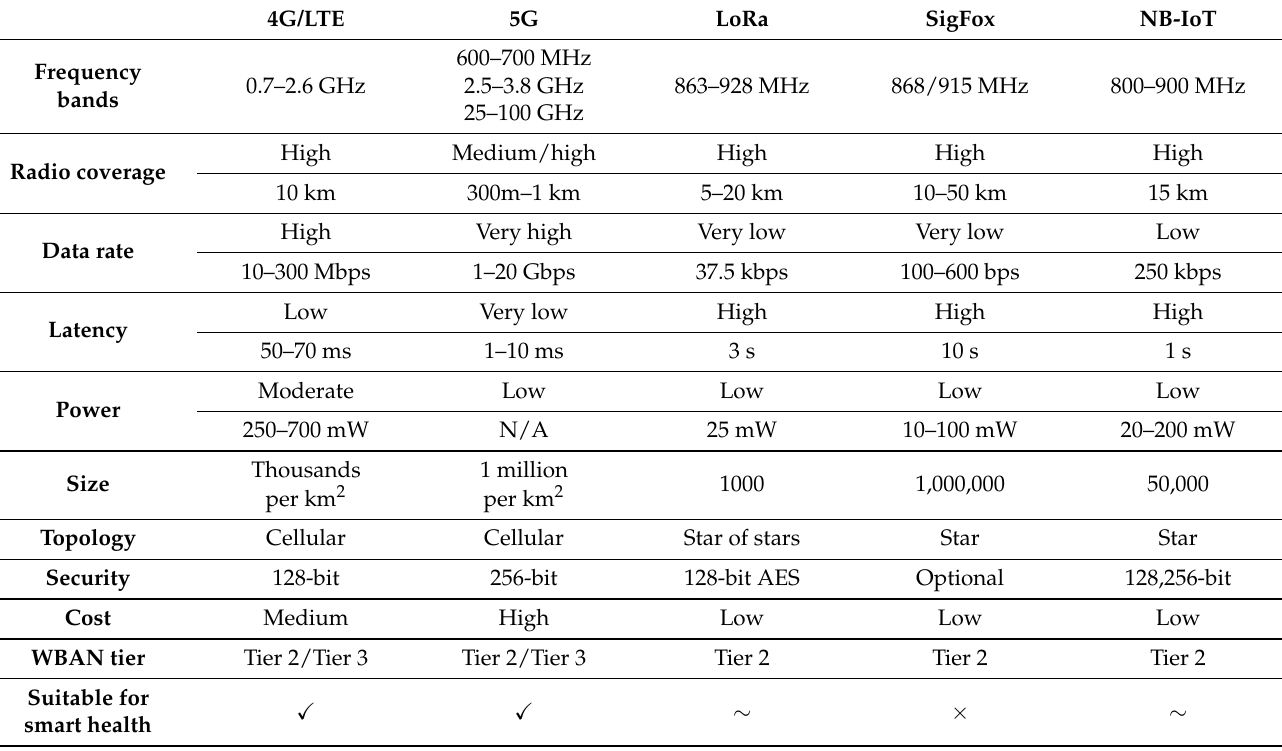
Table 12. Comparison of the main wireless communication technologies for smart healthcare (and II).